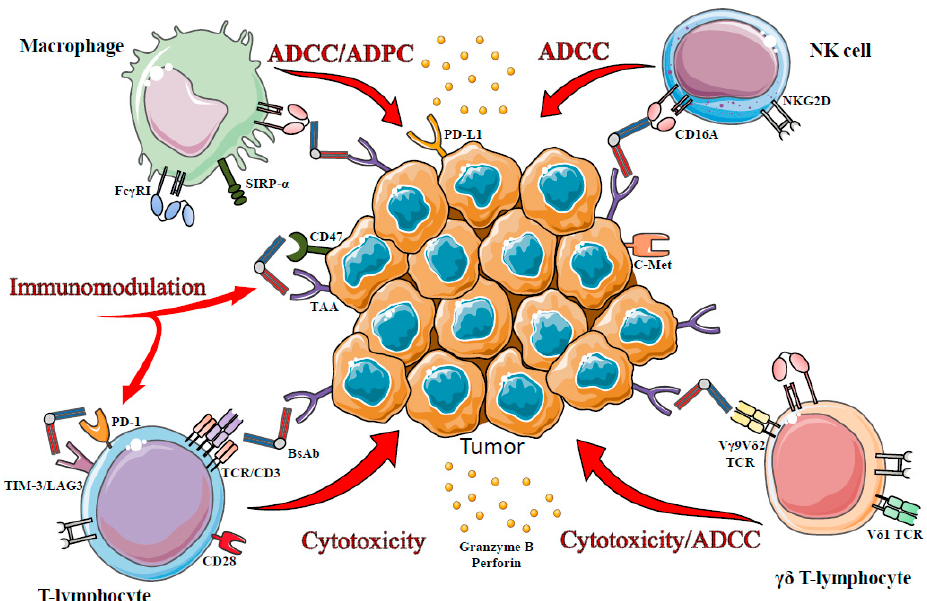
Figure 2. Immune effector cells targeted by bispecific antibodies. The mode of action of bispecific antibodies is related to the type of recruited immune cells: antibody-dependent cell-mediated cytotoxicity (ADCC) and antibody-dependent cellular phagocytosis (ADCP) are triggered by CD16A engagement on macrophages, NK cells or γδ T-cells; T-cell cytotoxicity is mediated by TCR/CD3 or V γ 9V δ 2 engagement or by blockade of immuno-checkpoints. Preclinical studies have shown that catumaxomab can target epithelial EpCAM + cells and human T-lymphocytes, and that the presence of the Fc fragment adds two major mechanisms to its efficiency. Firstly, it leads to an effective recruitment of NK cells and macrophages which results in strong ADCC and ADCP (picomolar range) [62,63]. Secondly and most importantly, the Fc fragment contributes to the co-stimulation of T-cells through direct contact with macrophages or DC (B7/CD28, CD40/CD40L, LFA3/CD2) and cytokine release (IL-2, IL-6, IL-12). In a multicenter prospective randomized phase 2/3 study, 258 cancer patients with recurrent symptomatic malignant ascites secondary to epithelial cancers were randomized to compare the intraperitoneal infusion of catumaxomab plus paracentesis with paracentesis alone in order to define its efficacy and safety [85]. This study showed that catumaxomab treatment significantly prolonged puncture free survival (drainage of fluid from the abdomen) (median 46 days) and decreased ascites symptoms in comparison